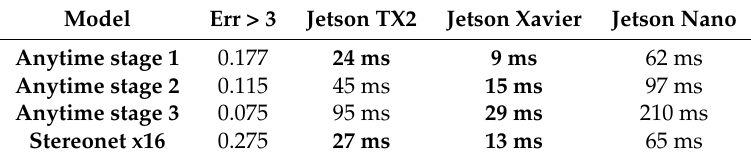
Table 4. Runtime and error performance for stereonet and anytime-stereo models after optimization techniques are applied. Anytime stage 1 corresponds to anytime-stereo disparity estimation at 1/16 of the original resolution, anytime stage 2 at 1/8, and anytime stage 3 at 1/4. Stereonet was used without refinement steps at 1/16 of the original resolution. In black real-time performance, lower is better. The disparity error (Err > 3) for each model is the same in all devices.